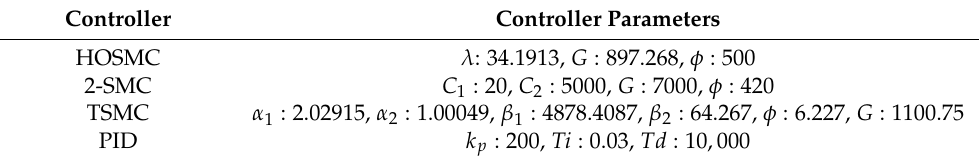
Table 9. Parameter table of the theta axis controller of a manipulator with fixed rotation inertia